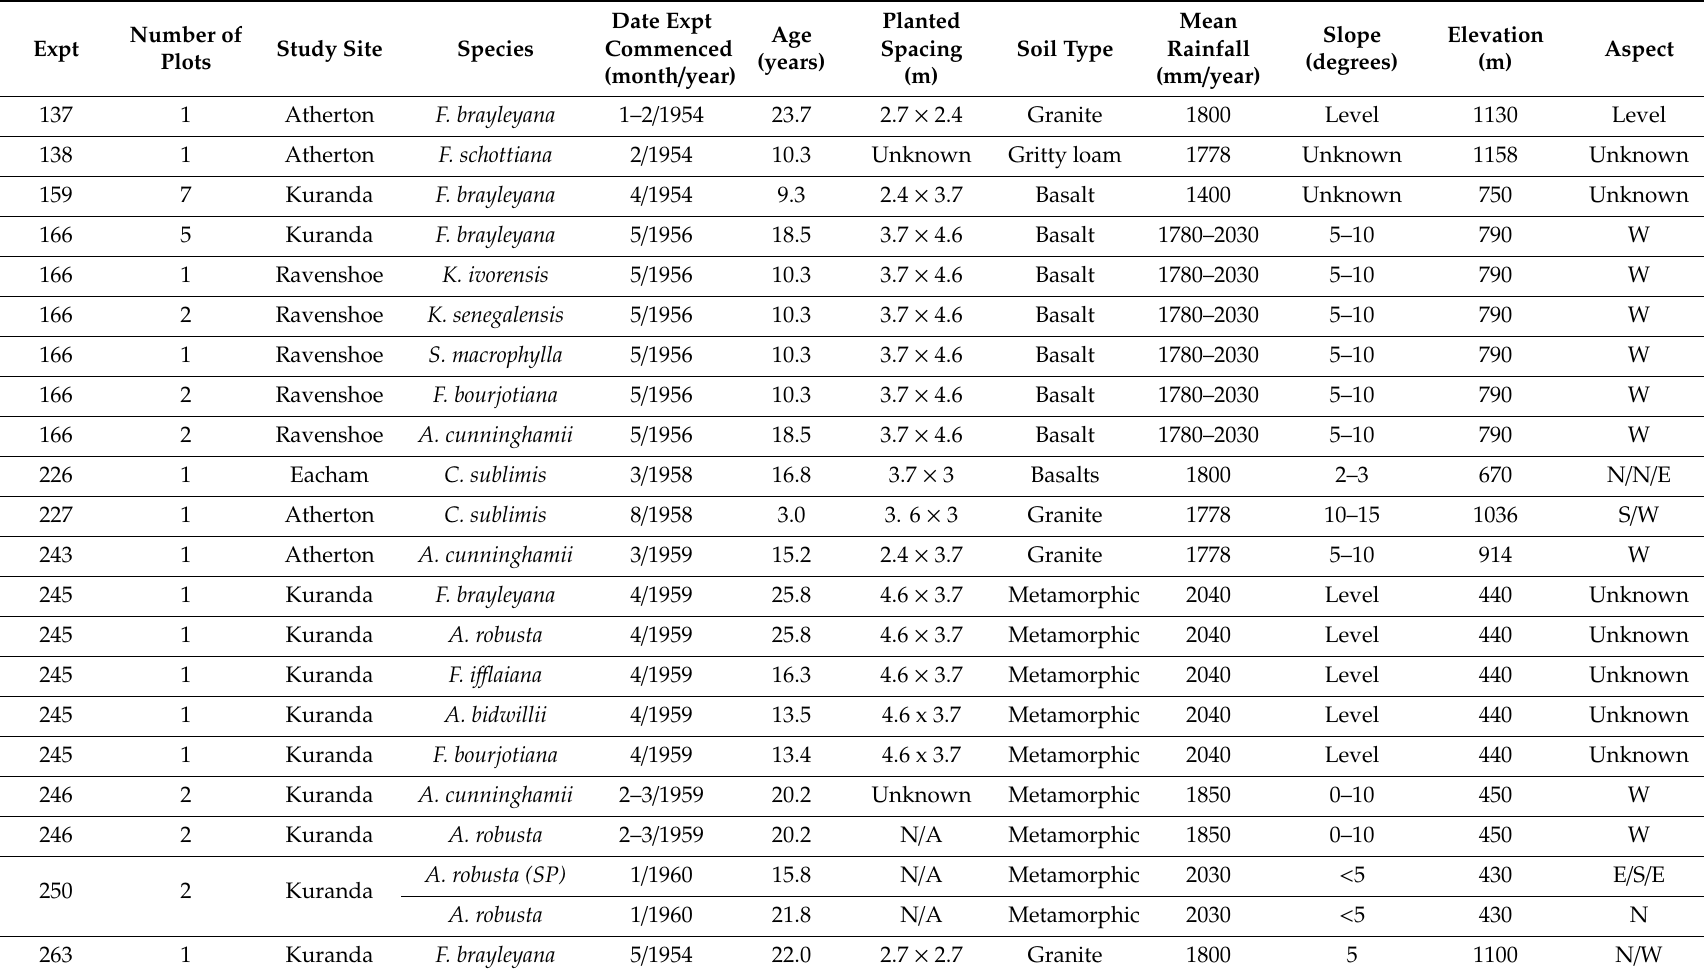
Table A1. Some characteristics of the enrichment planting experiments in north